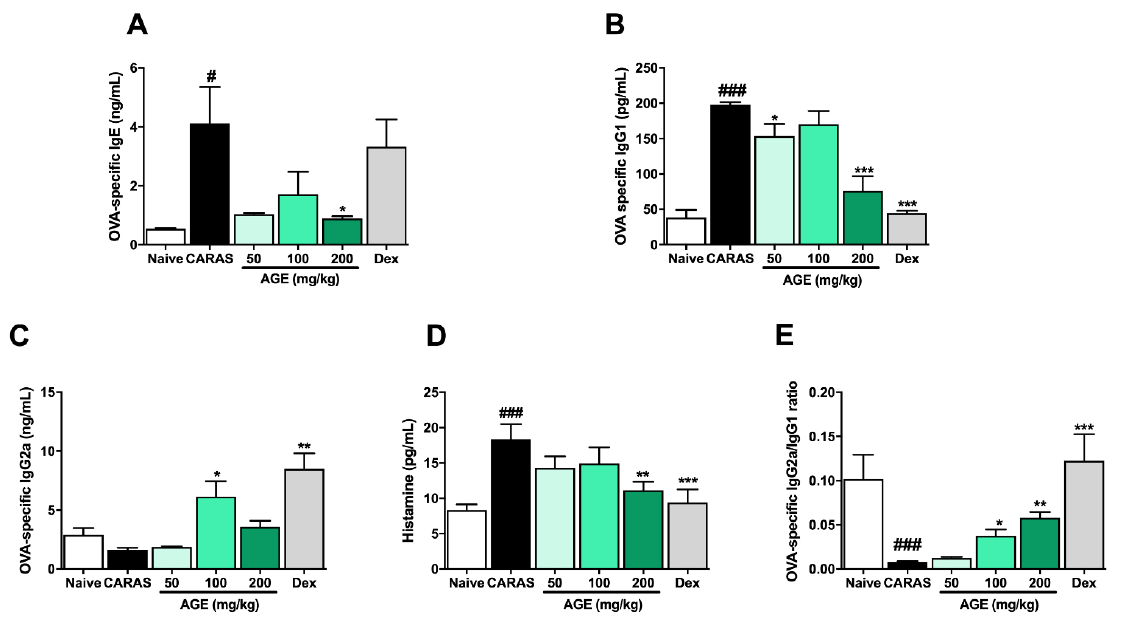
Figure 5. AGE suppressed allergic responses by regulating OVA-specific Igs in the serum of CARAS mice. ( A ) OVA-specific IgE, ( B ) OVA-specific IgG 2a , ( C ) OVA-specific IgG 1 , ( D ) OVA-specific IgG 2a /IgG 1 , and ( E ) histamine. Oral administration of AGE 200 mg/kg significantly down-regulated the levels of OVA-specific IgE, IgG1, and histamine. At the dose of 100 mg/kg, AGE also strongly up-regulated the level of OVA-specific IgG2a in the serum of CARAS mice. All results are shown as the mean ± SD (n = 6 per group). # Compared to naive, * compared to CARAS. ### , *** p < 0.001; ** p < 0.01, # , * p < 0.05. CARAS = combined allergic rhinitis and asthma syndrome; AGE = Artemisia gmelinii extracts; Dex = dexamethasone; Ig = immunoglobulins; OVA = ovalbumin. 2.6. AGE Increased TH1 Cytokines and TH1 Transcription Factor in NALF and BALF TH1 cytokines, such as IFN- γ, IL -12, and TH1 transcription factor T-bet, in both NALF (Figure 6A – C) and BALF (Figure 6D – F) were quantified by ELISA. The level of IL- 12 and T-bet in NALF and BALF were significantly decreased in the CARAS group compared with those in the naive group. The level of IL-12 was greatly improved by AGE 200 mg/kg. The level of T-bet was markedly enhanced by the administration of AGE 50, 100, 200 mg/kg, and Dex 2.5 mg/kg. However, there is no significant difference between groups in the level of IFN- γ in NALF. The level of IFN - γ in BALF in the CARAS group was considerably decreased compared with the naive group, while there was no statistical difference between the treated group and CARAS group.